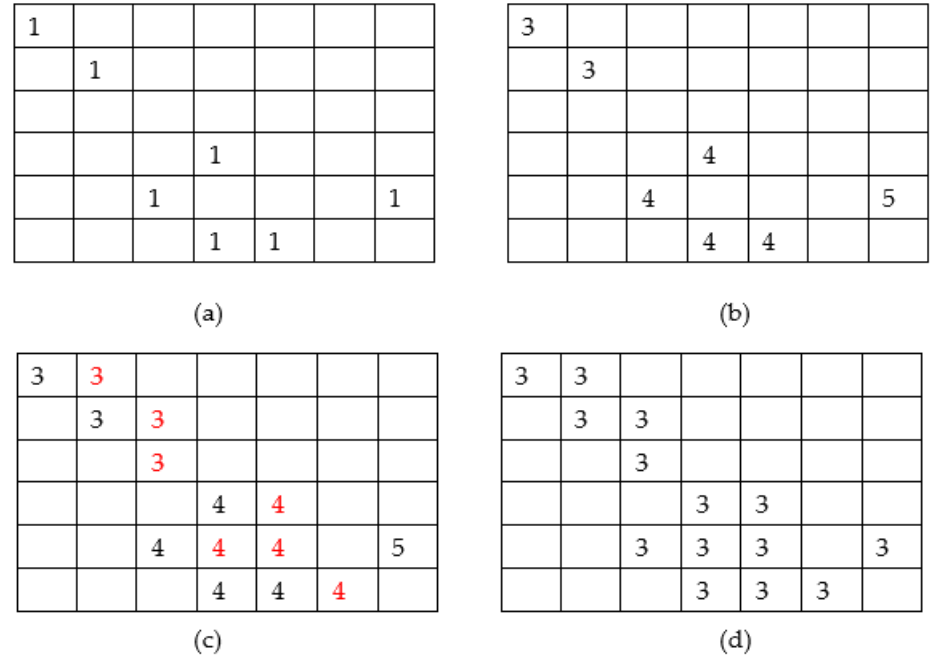
Figure 4. Example of edge pixels (1’s) in the edgesgm matrix ( a ), the initial assignment of values (the numbers 3–5) in edgesgm2 ( b ), the connection of disjointed edges with the red-colored numbers being the ones added in this process ( c ) and the merging of identities in connected edges ( d ). In order to determine the points that mark the borders of the fish parts, the fish contour is walked pixel by pixel, registering the corners (detected from direction changes) as landmarks. Using the morphology around the left and the right limits of the contour, the system recognizes the orientation of the fish. The location of the fish mouth can be easily determined in this case. On the opposite side, the area of the caudal fin is determined from the first corners of the upper and the lower part of the fish contour. For example, if the fish faces left, its mouth is at the point ( i,j ) on the contour with the lower j (pixel (0,0) is the upper left corner of the image). The line connecting the rightmost corners of the upper and lower part of the contour is used to delimit the caudal fin. The other corners of the upper and lower parts of the contour can be used to determine the position of the spiny or soft dorsal fins and the anal or pelvic fins, respectively. For example, three consequent corners may indicate the start, peak and the end of a fin. The line connecting the start and the end corner